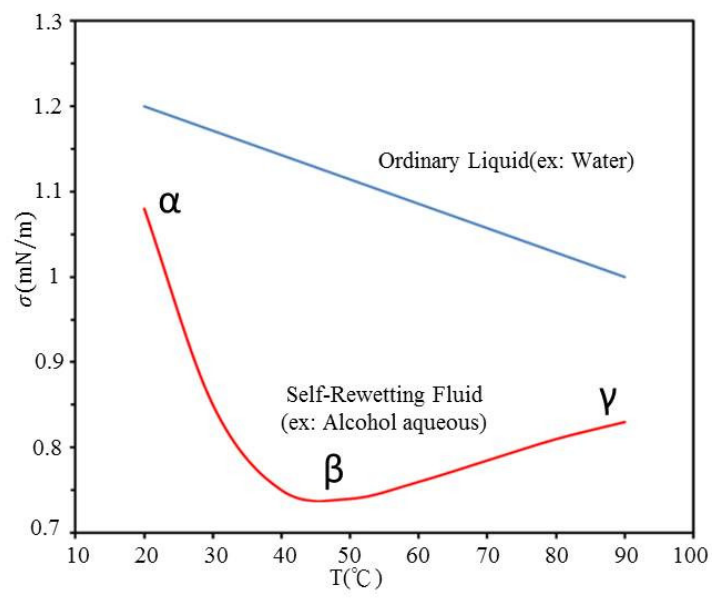
Figure 1. Identification of self-rewetting fluid [3].